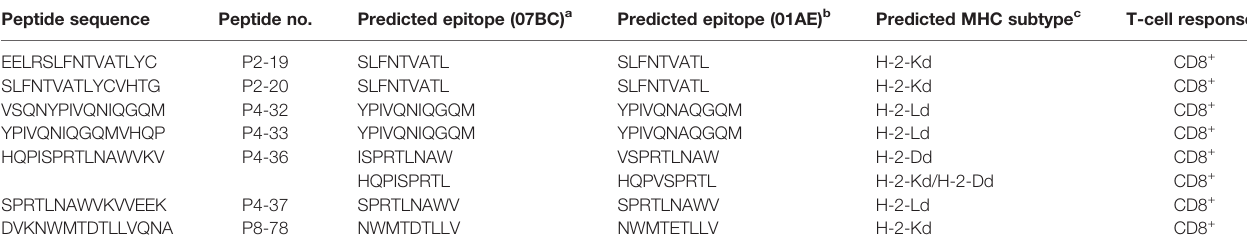
TABLE 2 | Prediction of the T-cell epitopes with cross-reactive T-cell responses between 07BC and 01AE. Peptide sequence Peptide no. Predicted epitope (07BC) a